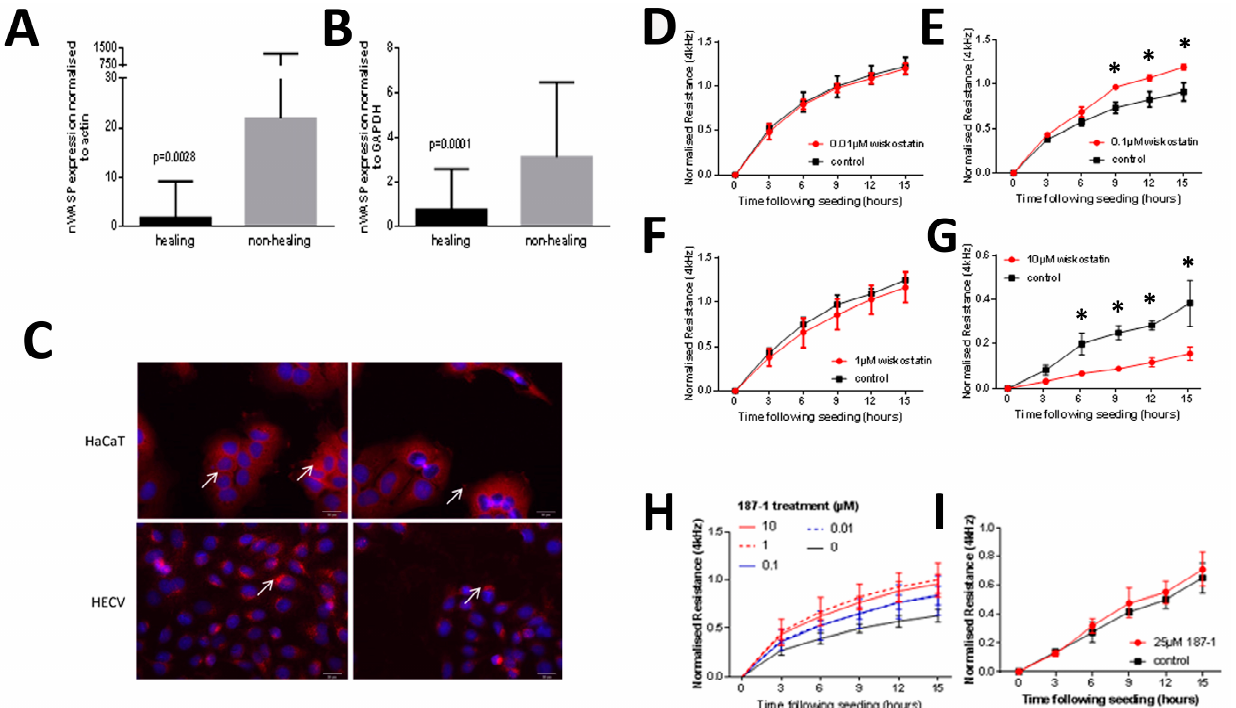
Figure 1. Analysis of nWASP in tissues and cells with the effect of the inhibitor treatment on the cell attachment. qPCR analysis of wound tissues from cohort 1 ( A ) and cohort 2 ( B ). Immunofluores- cence staining for nWASP in keratinocyte and endothelial cell lines; the scale bar is 100 µ m ( C ). The effect of wiskostatin on HaCaT attachment and spreading, as measured using ECIS ( D – G ). The effect of 187-1 treatment on HaCaT attachment and spreading, as measured using ECIS ( H , I ). * indicates statistical difference ( p < 0.05).